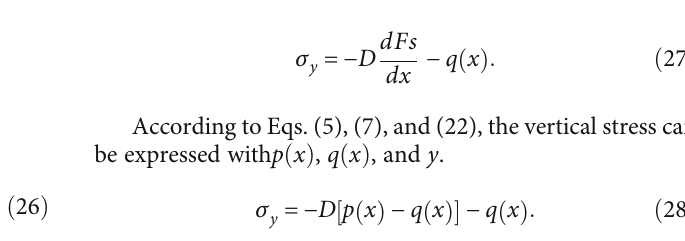
Figure 12: Vertical stress distribution of the key stratum #1 at top, middle, and bottom under various (a – c) E